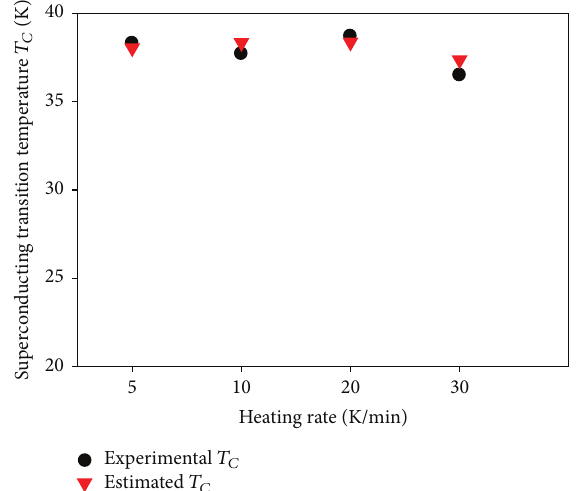
Figure4:Effectofheatingrateon 𝑇 𝐶 ofMgB 2 superconductorusing the developed